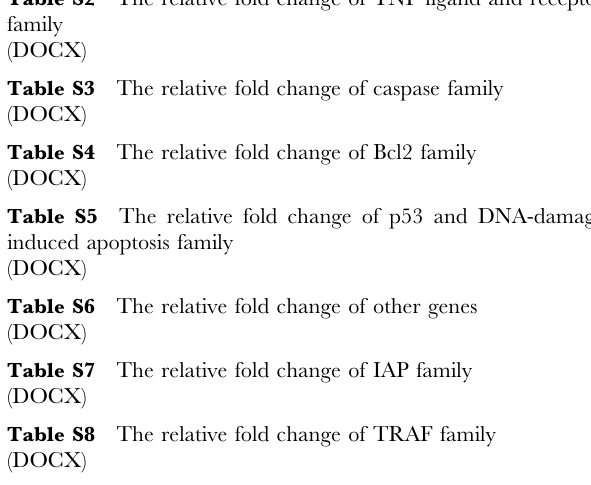
Table S2 The relative fold change of TNF ligand and receptor family Table S3 The relative fold change of caspase family Table S4 The relative fold change of Bcl2 family Table S5 The relative fold change of p53 and DNA-damage